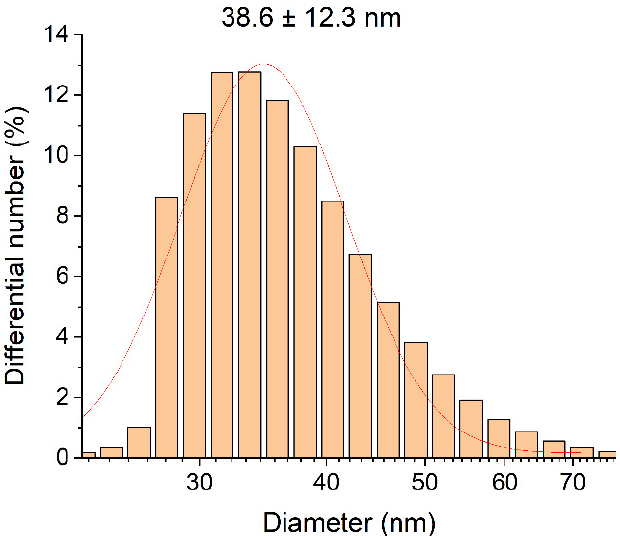
Figure 5. DLS diagrams of silver hydrosol Ag-Ag 2 O-NPs (20 nm) in liquid culture medium “Adkins M”. Consequently, the electromotive force ( ∆ E 0 ) of silver oxidation with participation of reactions indicated above is 0.179, 0.33, 0.553, and 1.092 V, respectively. In other words,